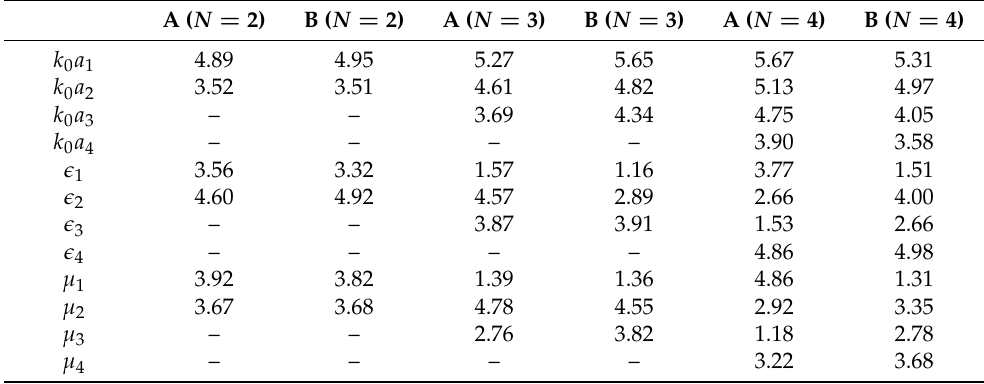
Table A6. Values of the optimization variables for optimized designs A and B of Figure 8.